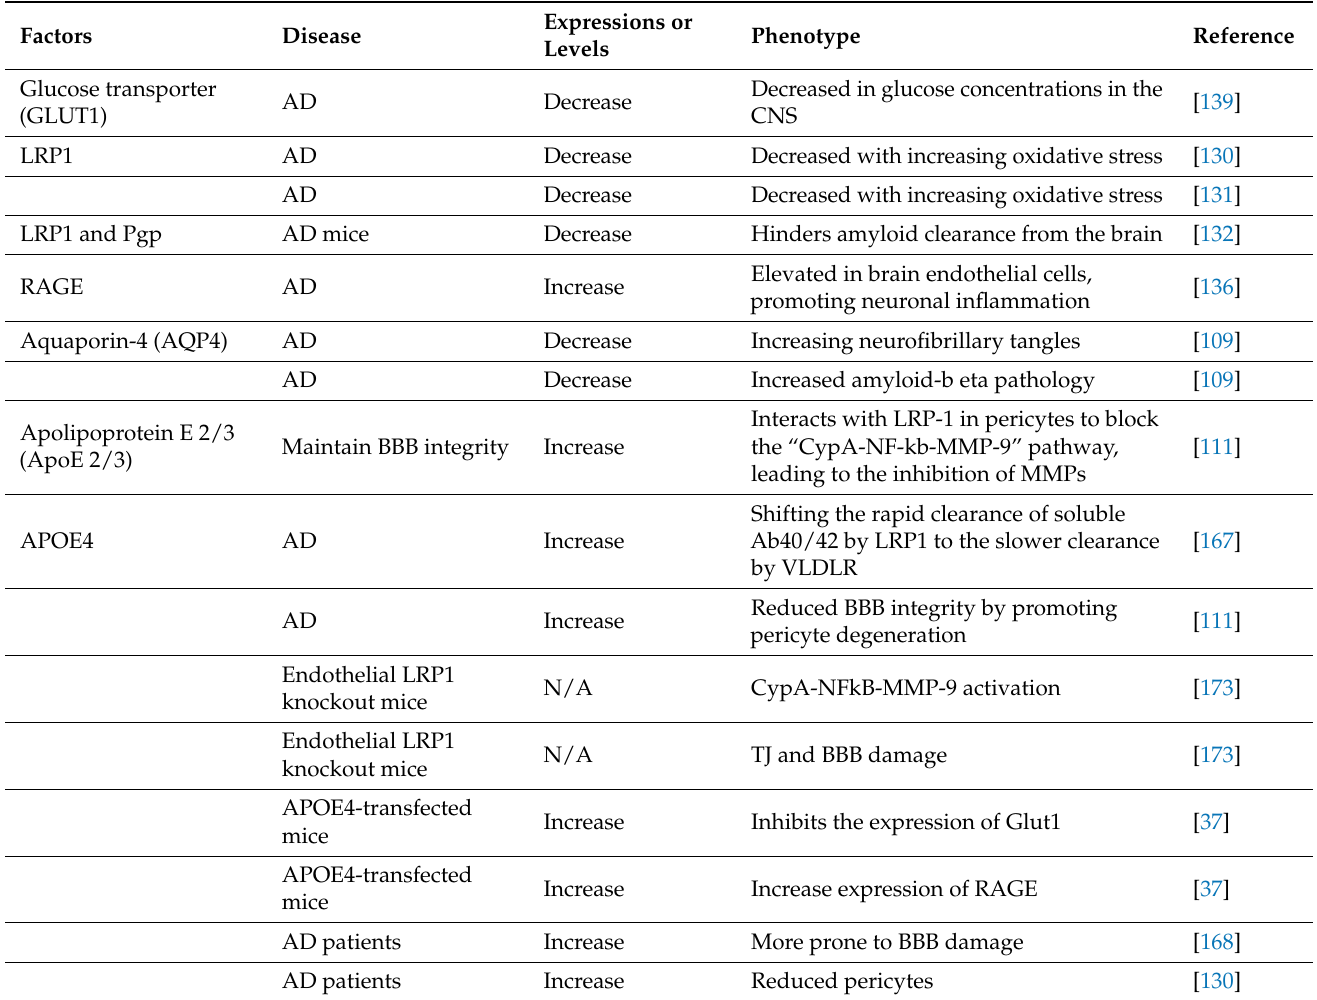
Table 2. Molecule factors of the BBB in aging, Alzheimer’s disease (AD), and vascular dementia